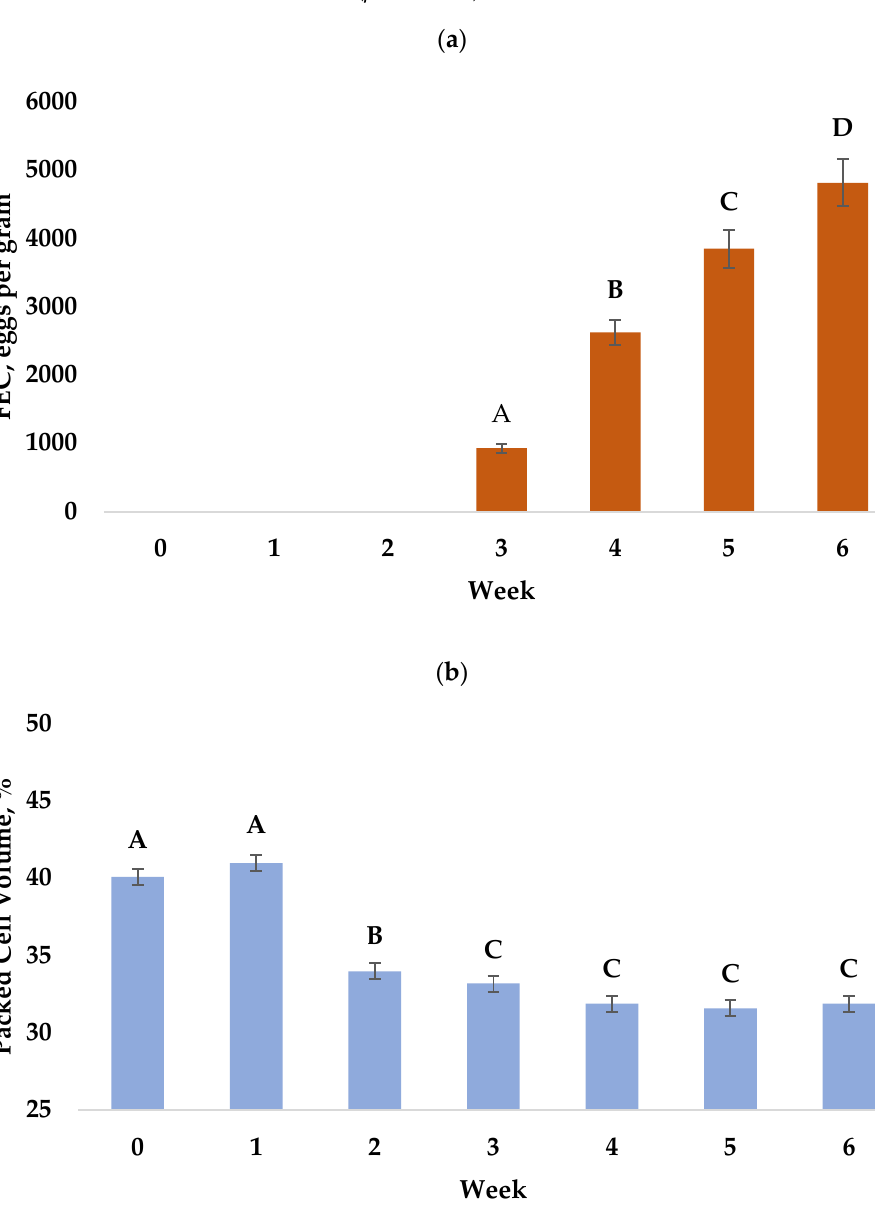
Figure 1. Response of Rambouillet lambs to an inoculation of 10,000 Haemonchus contortus L3 larvae. Indicators of parasite infection are displayed and include ( a ) mean fecal egg count and ( b ) mean packed-cell volume percentage for all lambs on the trial.